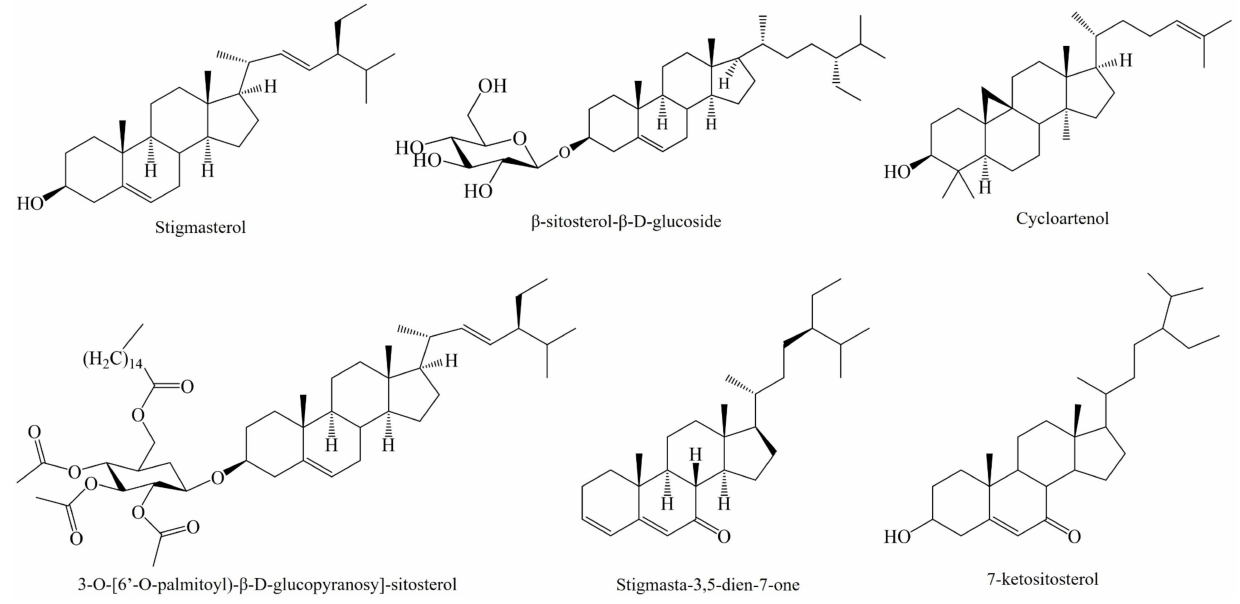
Figure 4. Current phytosterols identified and isolated in the Agave